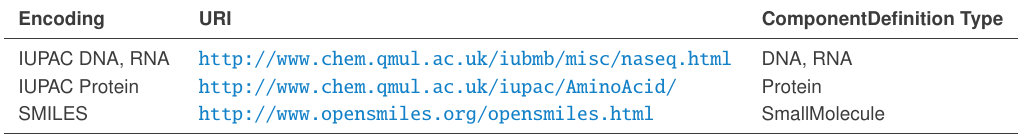
Table 1: URI s for specifying the encoding property of a Sequence , organized by the type of ComponentDefinition (see Table 2) that typically refer to a Sequence with such an encoding .